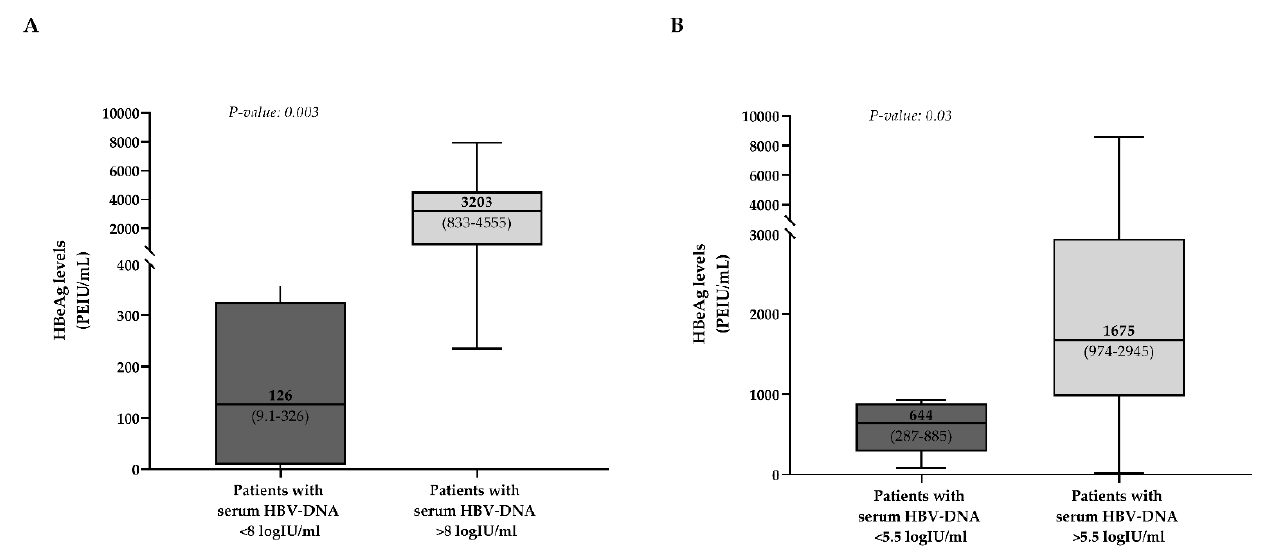
Figure 2. Distribution of HBeAg levels in patients stratified according to serum HBV-DNA in patients with acute HBV infection and immunosuppression-driven HBV reactivation. Boxplots report median, 25th and 75th percentile, min and max values of qHBeAg (expressed in PEIU/mL) in patients with acute infection ( A ) stratified according to serum HBV-DNA lower or higher than 8 logIU/mL and in patients experiencing immunosuppression-driven HBV reactivation ( B ) stratified according to serum HBV-DNA lower or higher than 5.5 logIU/mL. Statistically significant differences were assessed by the Mann–Whitney test.